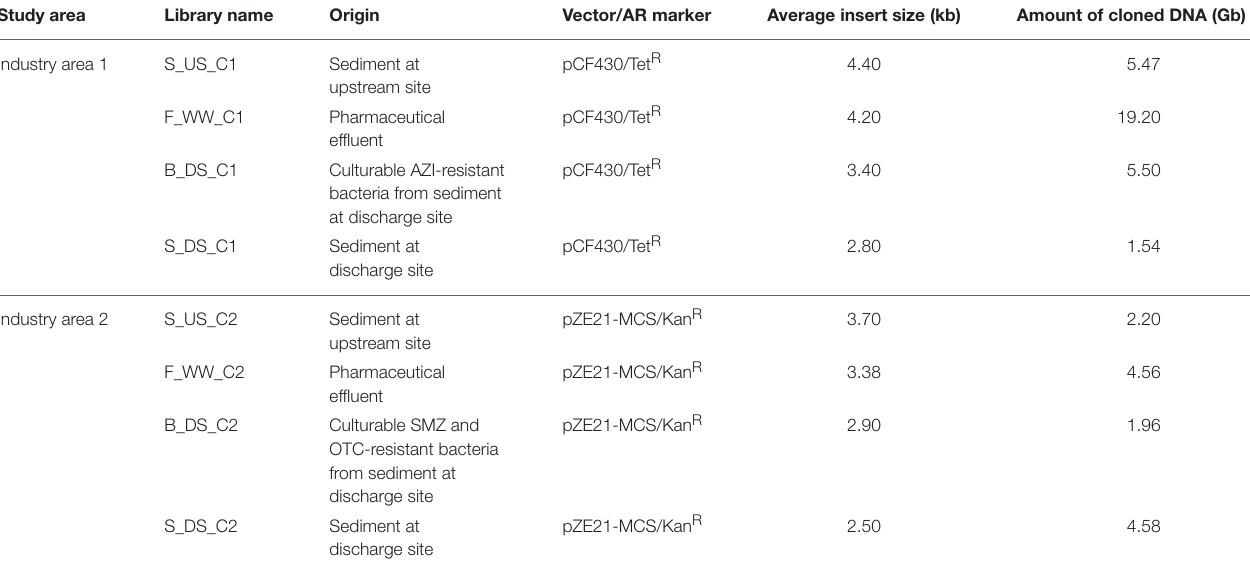
TABLE 1 | Features of the metagenomic libraries constructed in this